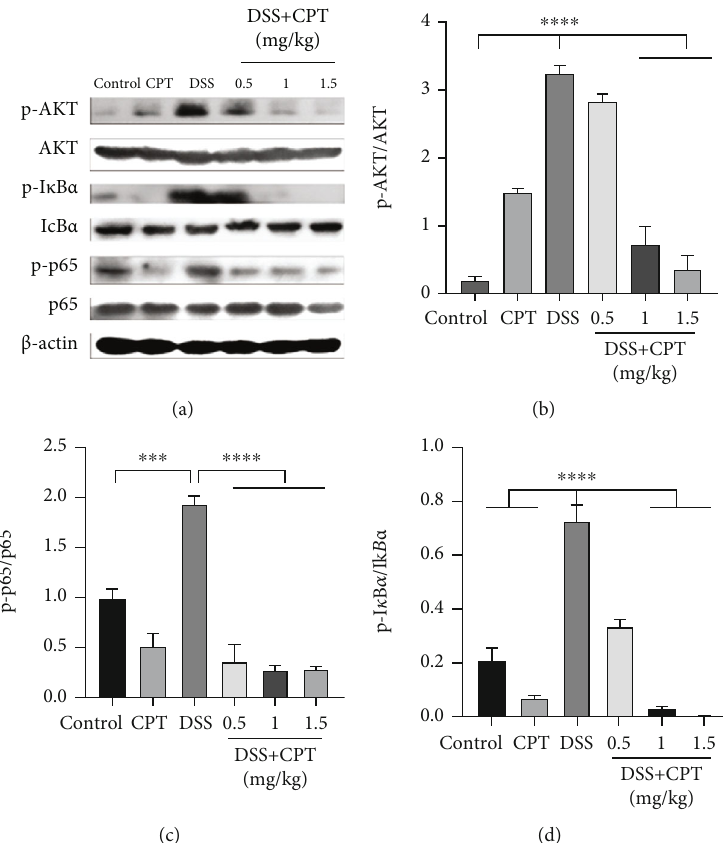
Figure 5: E ff ects of camptothecin (CPT) on the AKT/NF- κ B signaling pathway in DSS-induced ulcerative colitis in mice. Tissue lysates were prepared and subjected to western blot using (a, b) p-AKT, (a, c) p-I κ B α , and (a, d) p-p65 antibodies. The p-AKT, p-p65, and p-I κ B α immunoreactive bands were digitized and expressed as a ratio of AKT, I κ B α , and p65 levels (b – d). Values are presented as mean ± SD ( ∗ P < 0 : 05 , ∗∗∗ P < 0 : 001 , and ∗∗∗∗ P < 0 : 0001 vs. the LPS